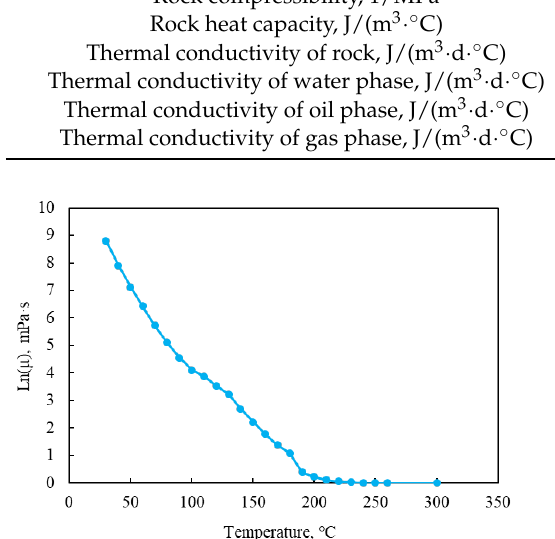
Figure 6. Viscosity – temperature curve of the heavy oil.